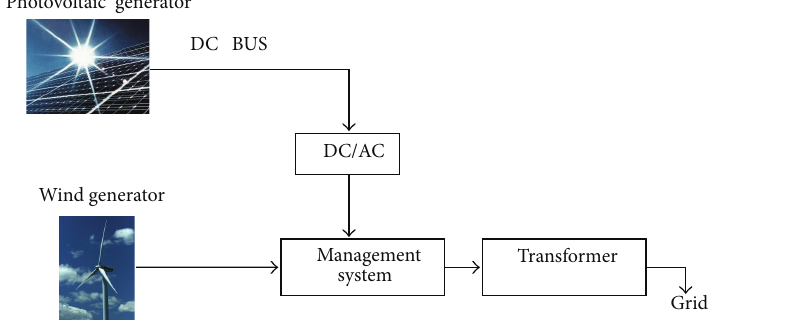
Figure 1: Decentralized installation connected to the grid.